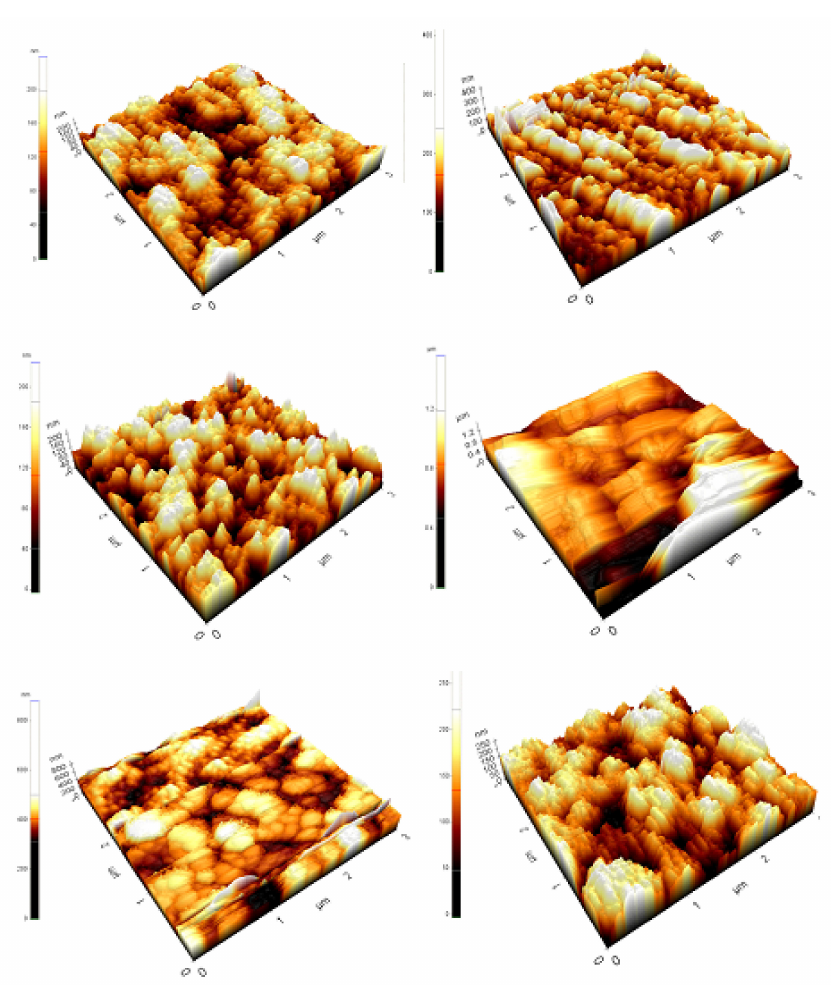
Figure 6. Atomic force microscope (AFM) images of the SnS films sulfurized at different time